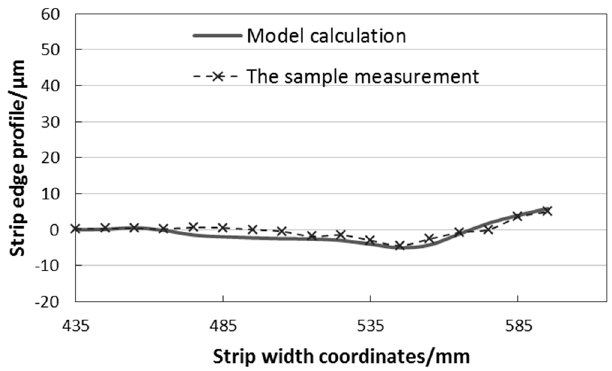
Figure 6. Comparison of model calculated value of strip edge profile with sample measurement.